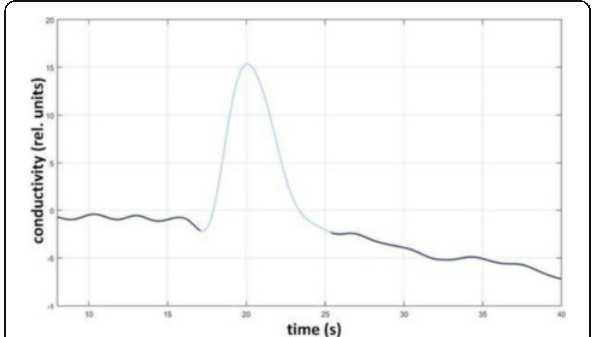
Fig. 120 (abstract A314). Example of peak in conductivity caused by the hypertonic saline bolus within the pixel representing the aorta; the dark blue line shows the filtered conductivity signal, while the light blue line marks the bolus event